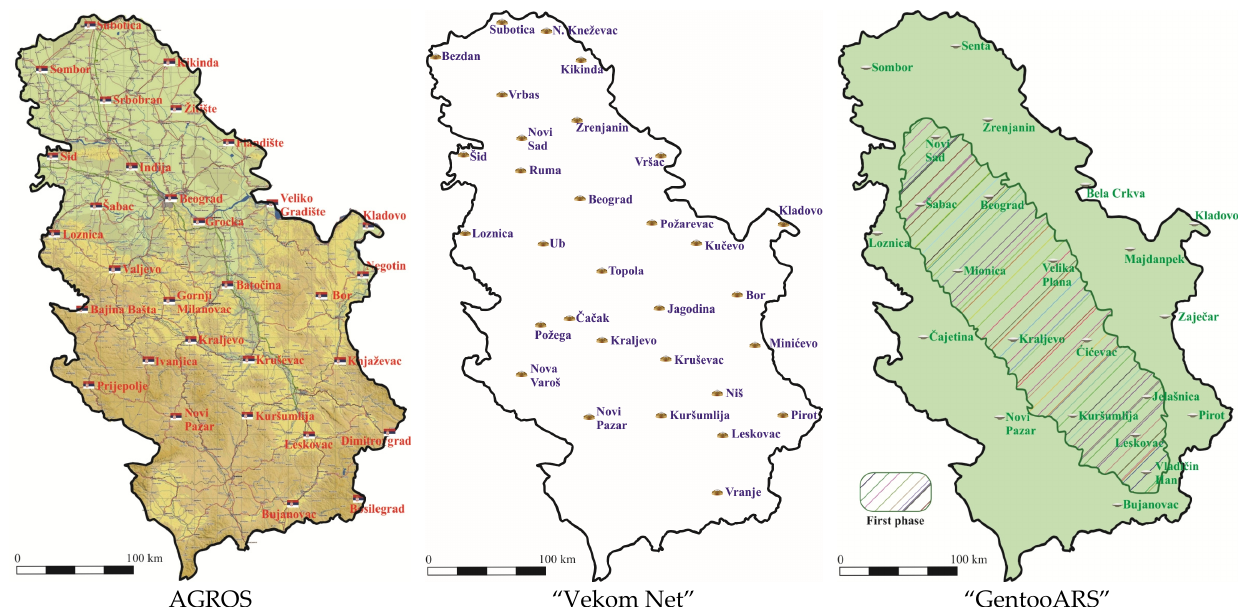
Figure 1. GNSS Networks in the Republic of Serbia.